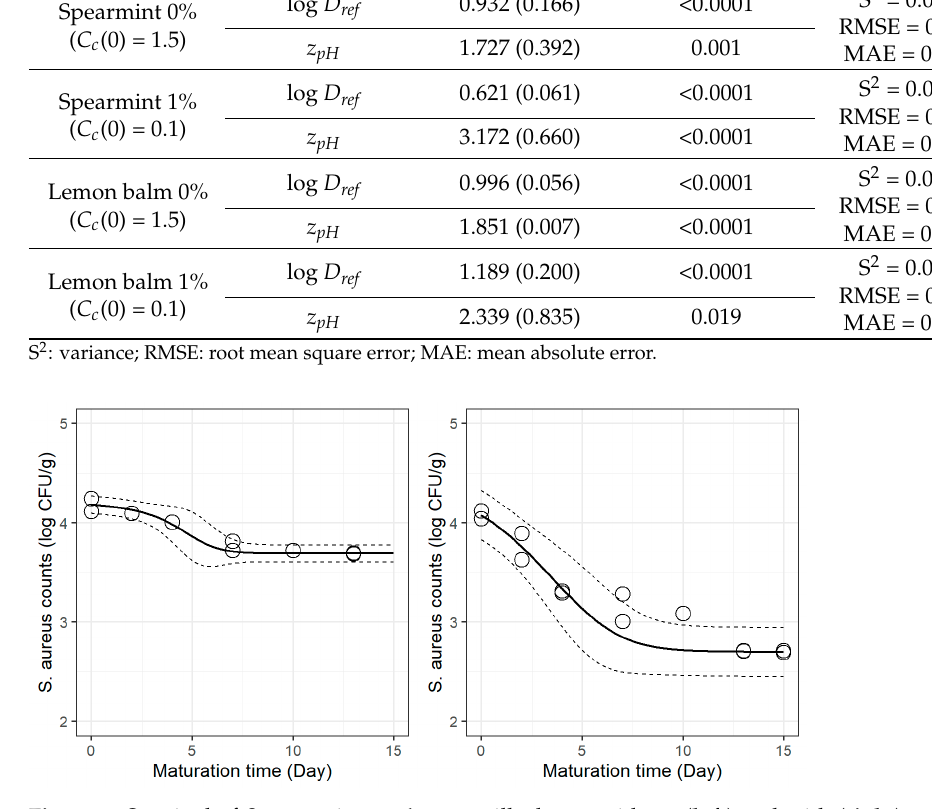
Table 1. Effect of adding 1% spearmint extract and 1% lemon balm extract in curd on the Bigelow’s inactivation parameters of Staphylococcus aureus in goat’s raw milk cheese during maturation. Treatment